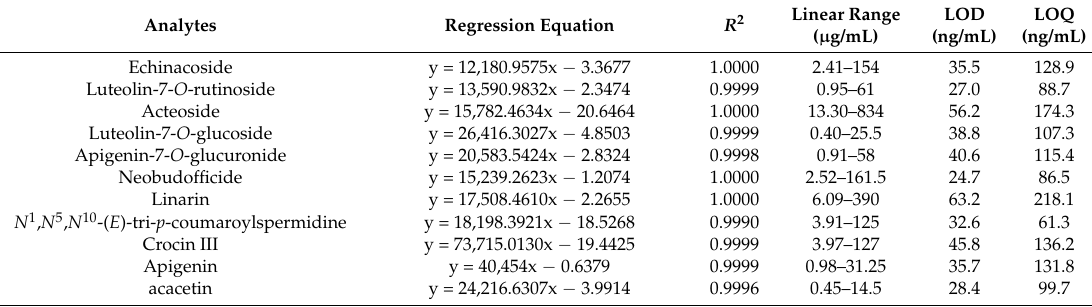
Table 5. Calibration curves, linear range, LOD and LOQ of 11 reference compounds.